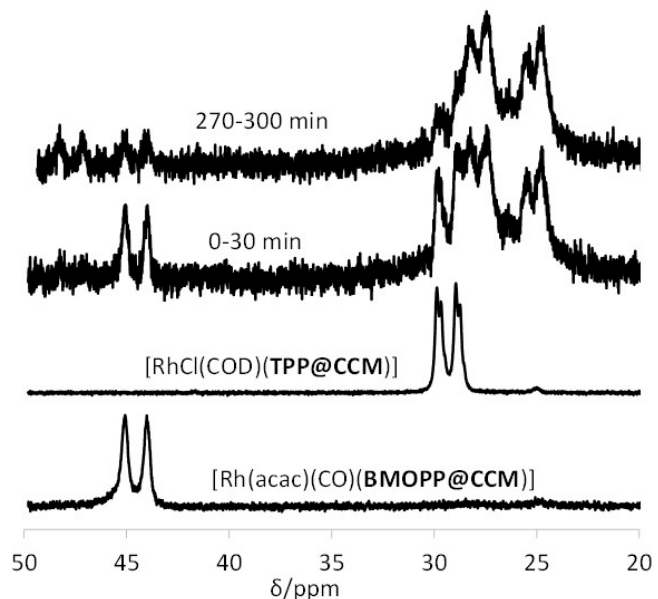
Figure 8. 31 P{ 1 H} NMR spectra of the latex obtained by mixing equimolar amounts of [Rh(acac)(CO)(BMOPPP@CCM)] and [RhCl(COD)(TPP@CCM)]. The data for each spectrum were collected for 30 min; the time intervals for data collection from the time of mixing are indicated on each spectrum. The spectra of the starting latexes are also included for comparison.